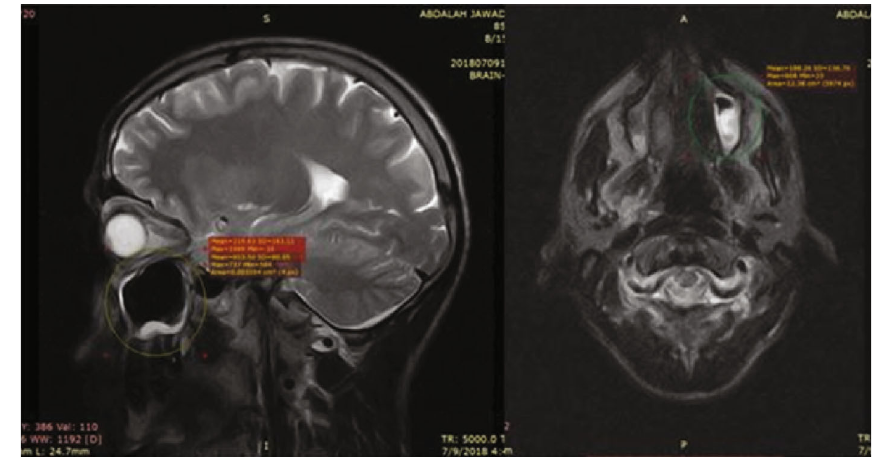
Figure 1: MRI sagittal and axial views show thickness of mucosal layer of maxillary sinus.